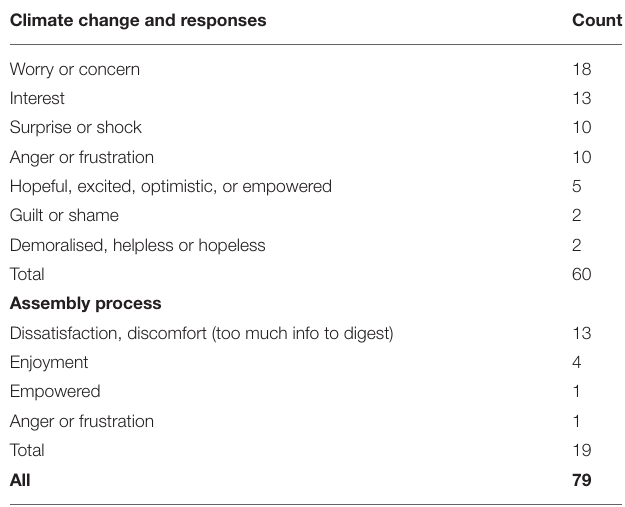
TABLE 4 | Emotional expression in 26 small group sessions (total of 23h